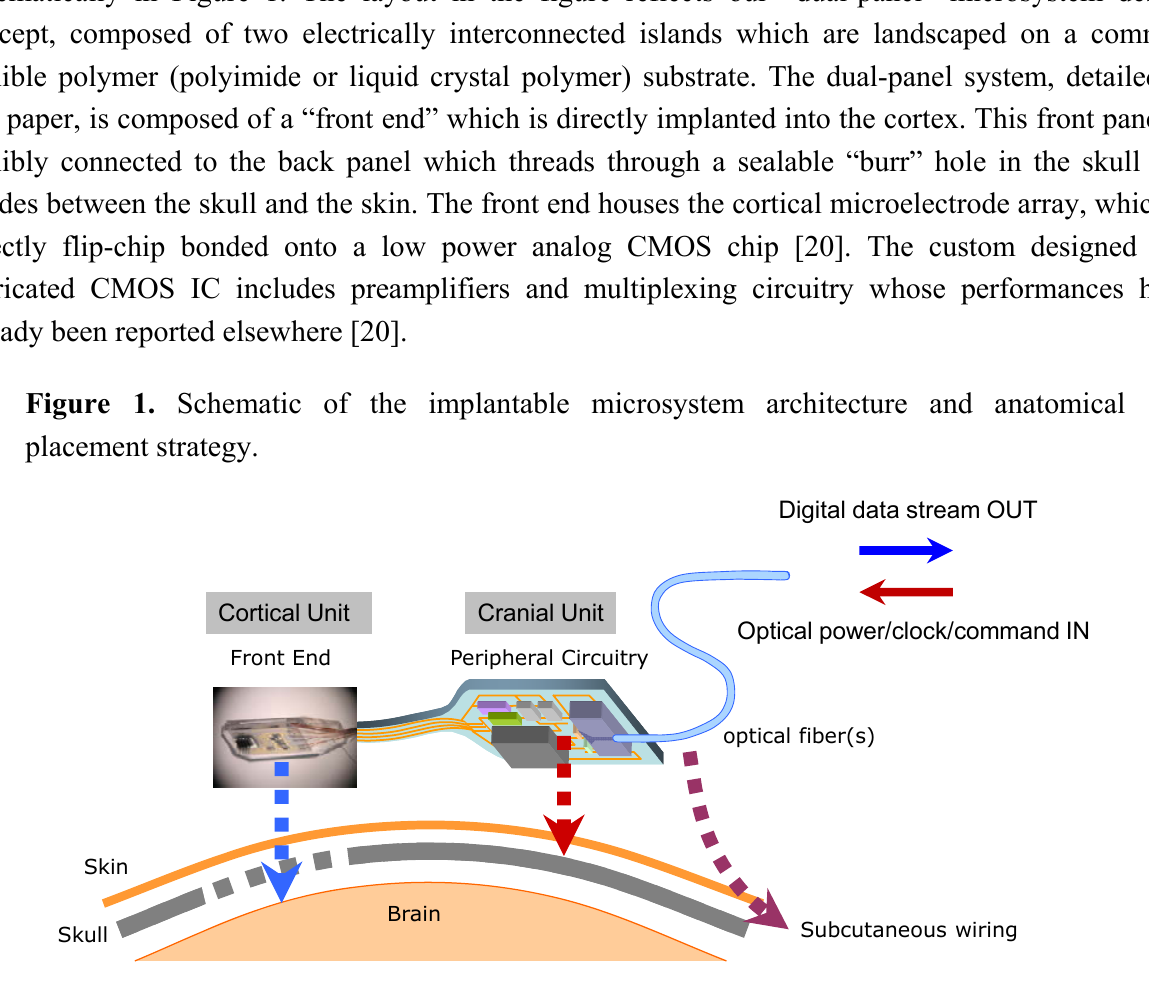
Figure 2. Block diagram for the implantable microsystem detailing the key micro- and optoelectronic on-chip circuit